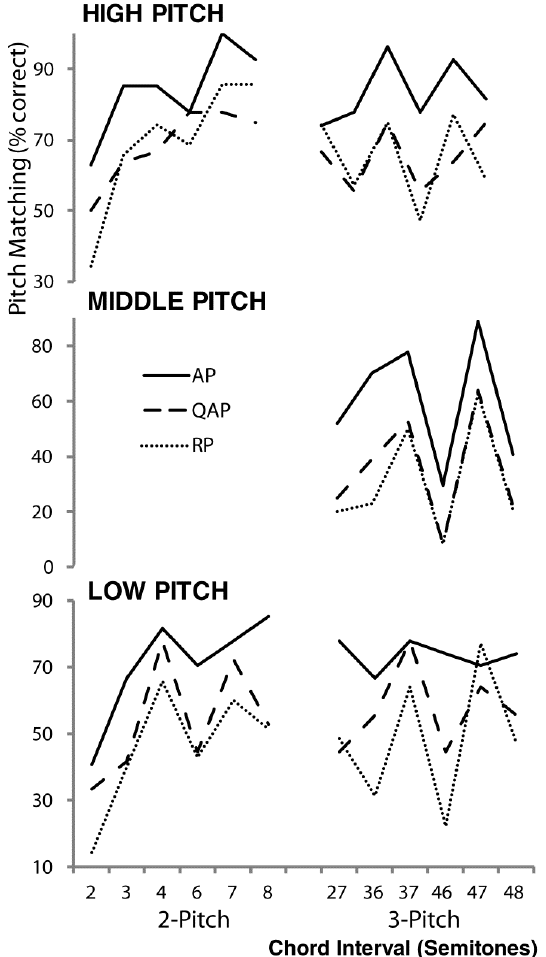
Figure 3. Pitch matching accuracy of the three musician groups for the high, middle and low pitch of the 2- and 3-pitch chords described in Table